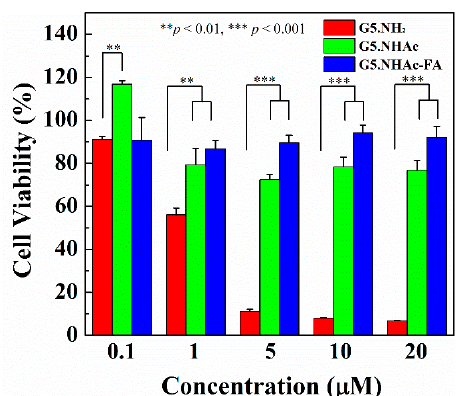
Figure 4. The viability of KB cells treated with G5.NH 2 , G5.NHAc, and G5.NHAc-FA dendrimers at different concentrations.